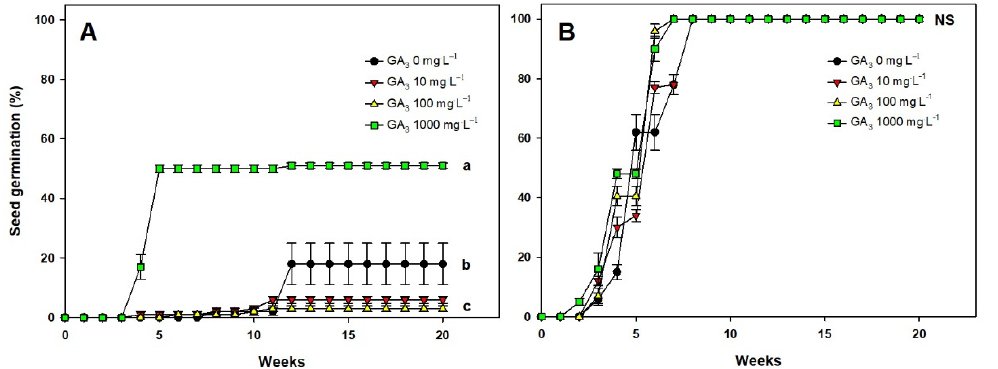
Figure 6. Germination of Hovenia dulcis seeds with gibberellic acid treatment after ( A ) no scarification and ( B ) 98% sulfuric acid scarification for 1 h. Vertical bars show ± SE of four replicates. The different letters represent statistically significant differences for germination percentages according to treatments in the 20th week as determined by Duncan’s multiple range test ( p < 0.05).